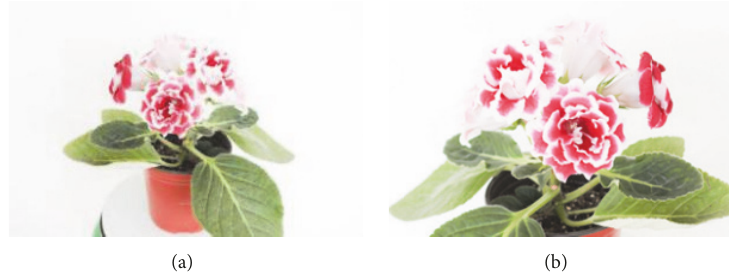
Figure 4: Extract features by cutting image. (a) The original image and (b) the cropped image.